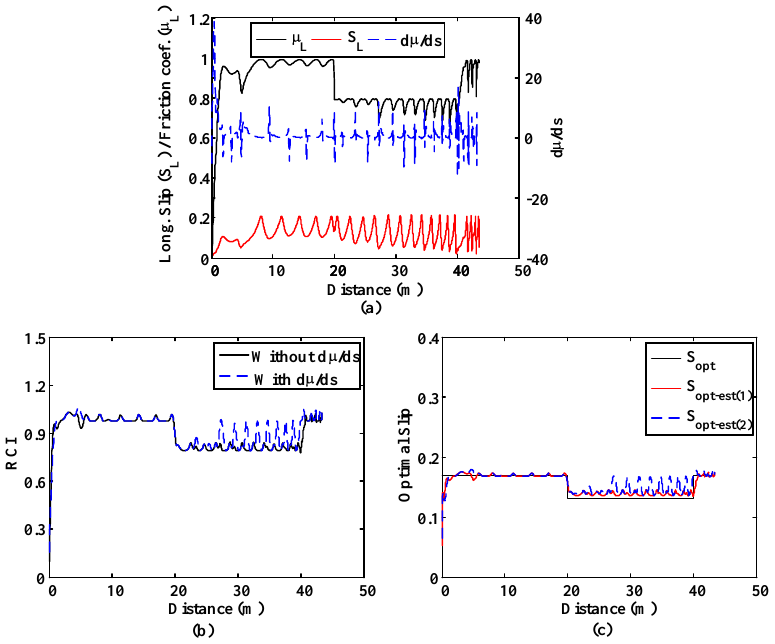
Figure 15. Straight line simulation. Surface transition: 20 m. on µ = 1, 20 m. on µ = 0.4 and 40 m. on µ = 1. ( a ) Friction coefficient, slip and d µ /ds; ( b ) Road condition fuzzy block outputs comparative; ( c ) Optimal slip comparative.